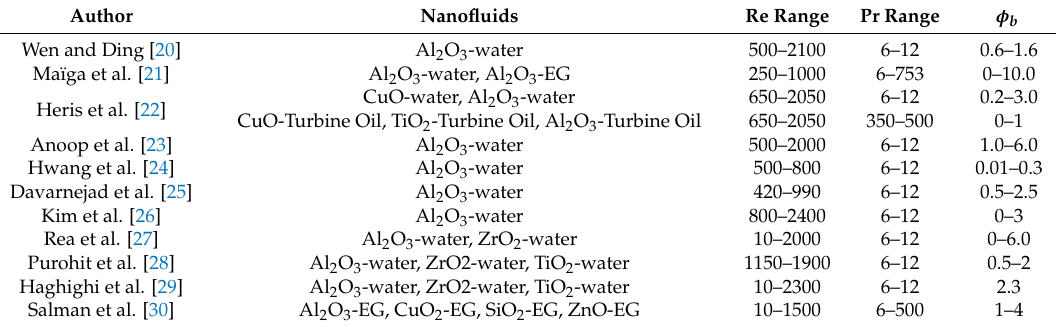
Table 1. The different nanofluids and their process